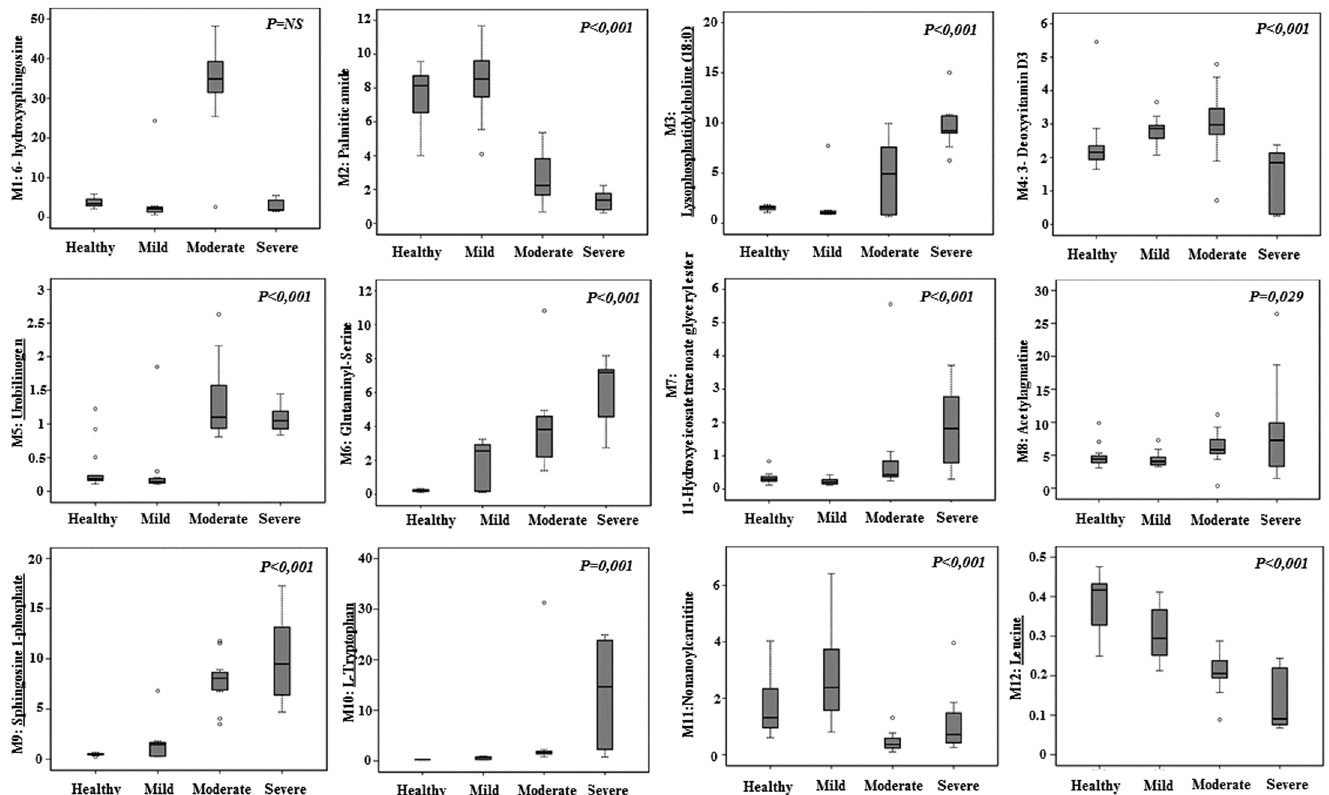
Fig 2. Whisker plots showing significant correlations between plasma metabolite levels and severityof the disease in CMT1A patients. Determination of the plasma levels of the 12 selectedmetabolites after forward stepwise LinearDiscriminant Analysis was carried out by UHPLC-MS and groupedconsidering severity of the diseaseas assessed by the CMT neuropathyscore (secondversion). Healthy subjects (n = 15), Mild (n = 15), Moderate (n = 18) and Severe (n = 9) groups of CMT1A patients are represented. Identification of the metabolites was achievedby matching the obtained accurate m/z to those publishedin appropriated databases (see S2 Table) and when available,by co-elution of commercial standards with the extracted ion chromatograms of plasma samples (highlightedin red). Box plots represent the lowest, lower quartile, median,upper quartile, and highest observations of each marker in the different groups. (cid:14) , outlier values P- value is calculatedby analysisof variance; r is the Spearmancoefficient